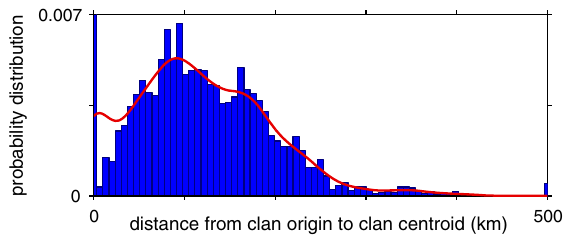
FIG. 11. Probability distribution for how far clans have moved in terms of the distance from the historical clan origin location to the clan centroid from 2000. We geographically identified the origin and centroid for 3 900 clans among the 4 303 clans in the 2000 census data. The rightmost bar corresponds to all distances of at least 500 km, and the solid curve is a kernel density estimate (from M ATLAB R2011a ’ s KSDENSITY function with default